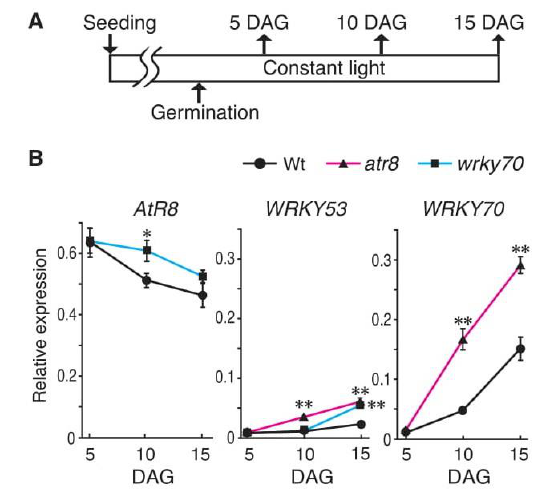
Figure 7. Time course of the RNA accumulations soon after germination. ( A ) Timeline of the experimental procedure. Up arrows indicate samplings. The Wt, atr8, and wrky70 strains were germinated on 0.24% gellan gum media (without SA and P. syringae) , and the total RNAs were extracted after the indicated periods (DAG: days after germination) from each strain, and subjected to RT-qPCR with ACT2 and ACT8 genes as standards. ( B ) Line graphs represent the mean values of three independent assays (≥ 60 plants), and error bars represent ±SE. Significant differences in RNA accumulation levels between Wt and each of the mutants (Wt and atr8, Wt and wrky70) are indicated as * p < 0.05 and ** p < 0.01 (Welch ’ s t -test).